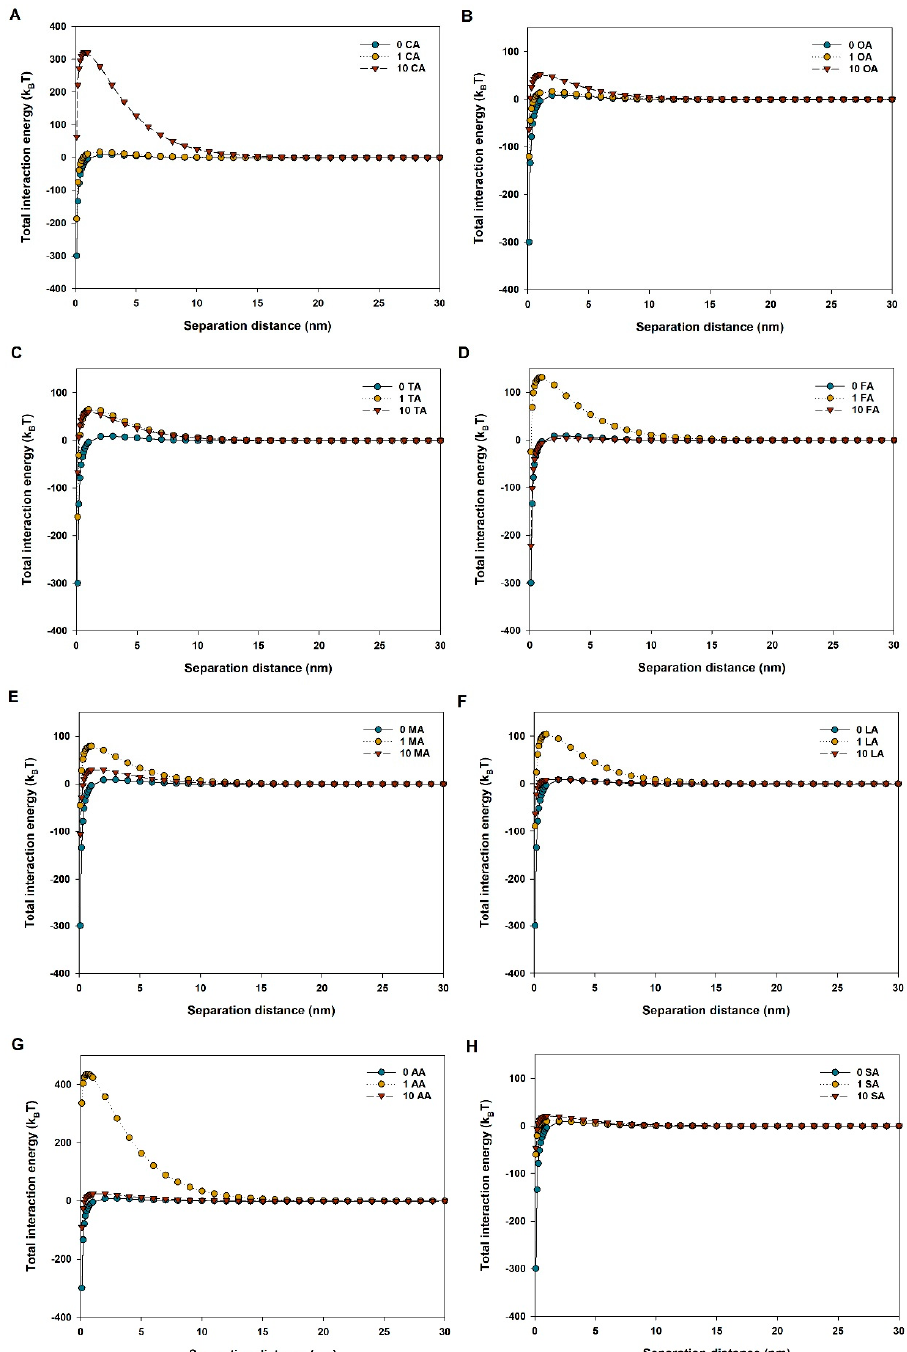
Figure 4. Calculated Derjaguin–Landau–Verwey–Overbeak (DLVO) total interaction energy between two CuO NPs (100 mg / L) in the presence of di ff erent LMWOAs. ( A ) CA: Citric acid; ( B ) OA: Oxalic acid; ( C ) TA: Tartaric acid; ( D ) FA: Formic acid; ( E ) MA: Malic acid; ( F ) LA: Lactic acid; ( G ) AA: Acetic acid; ( H ) SA: Succinic acid.